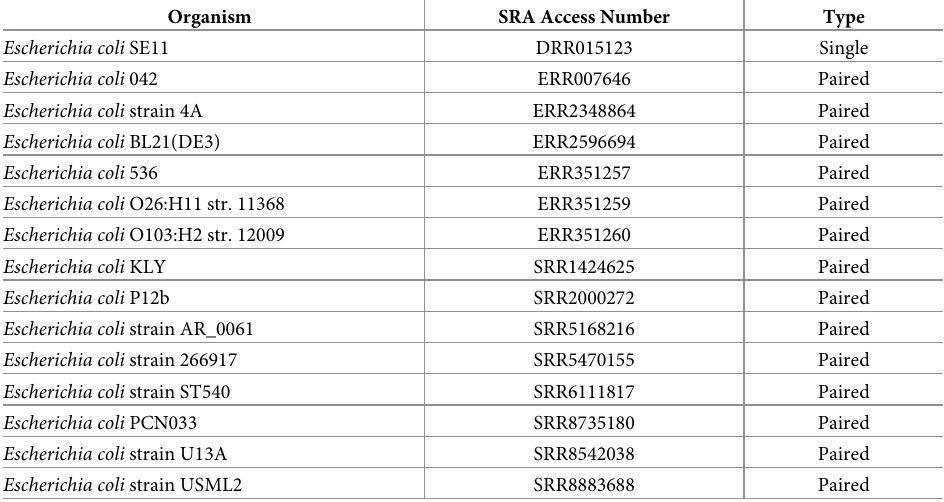
Table 1. List of data used to validate the PAN2HGENE tool.